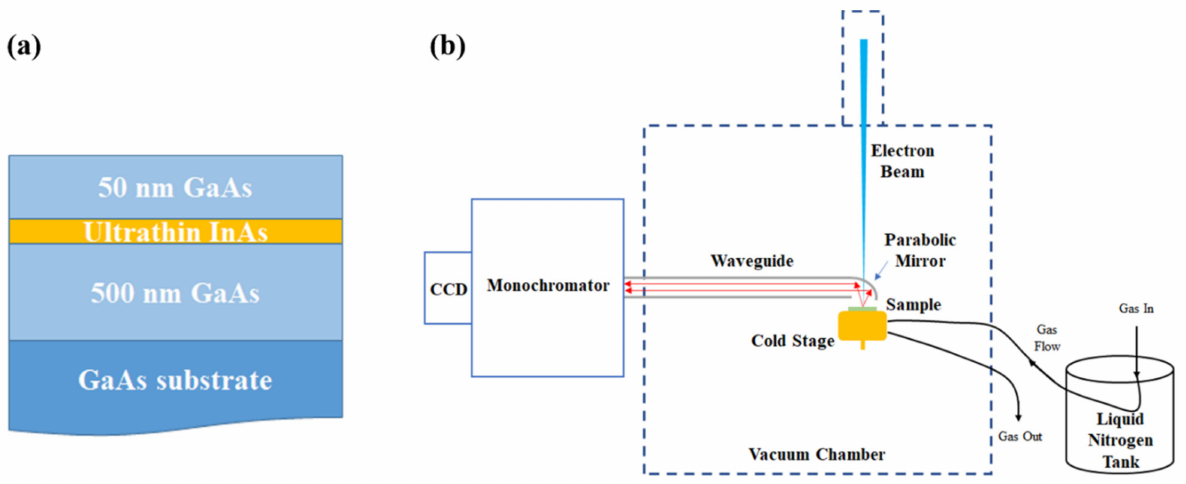
Figure 1. ( a ) Schematic of the sample structure from the cross-section view. ( b ) Schematic of the CL